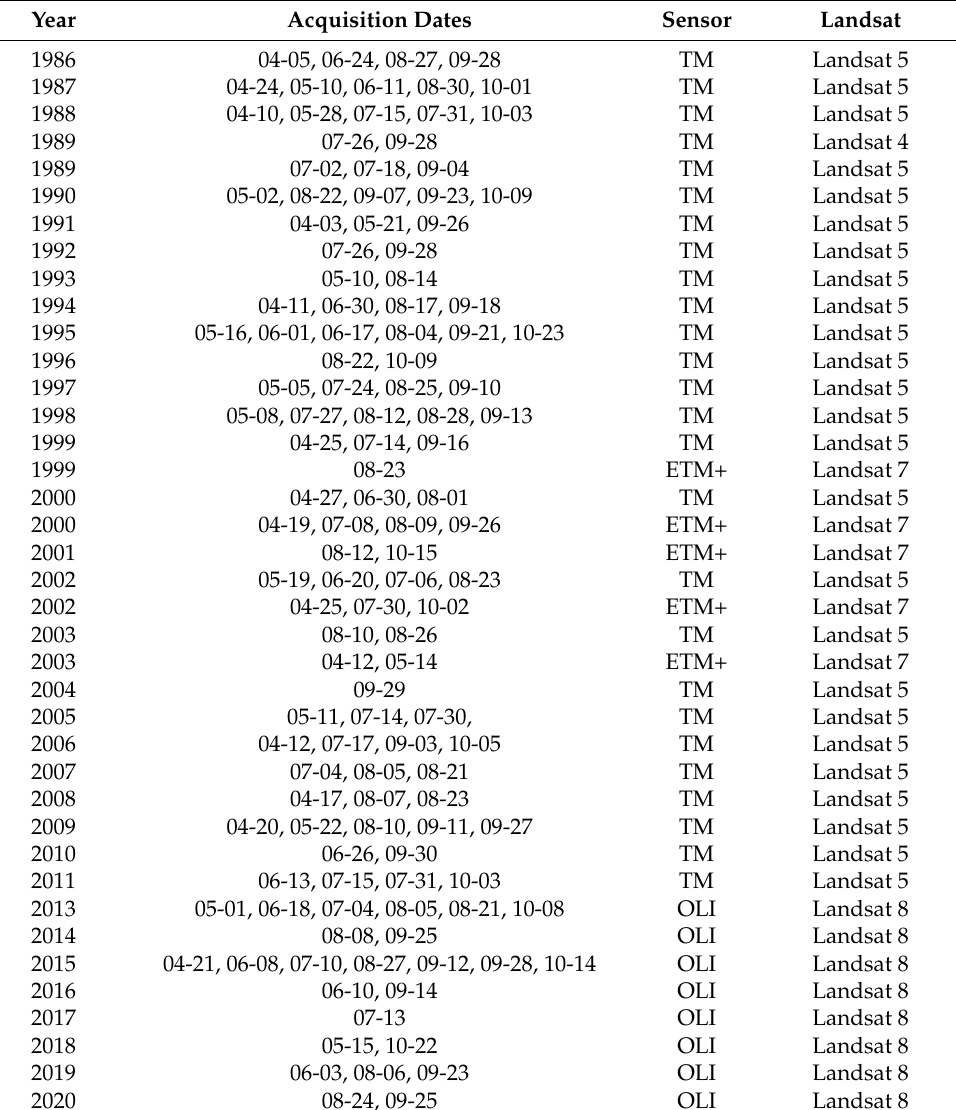
Table 1. Landsat Collection 2, Level 2 images acquired for temporal analysis of Grasslands Na- tional